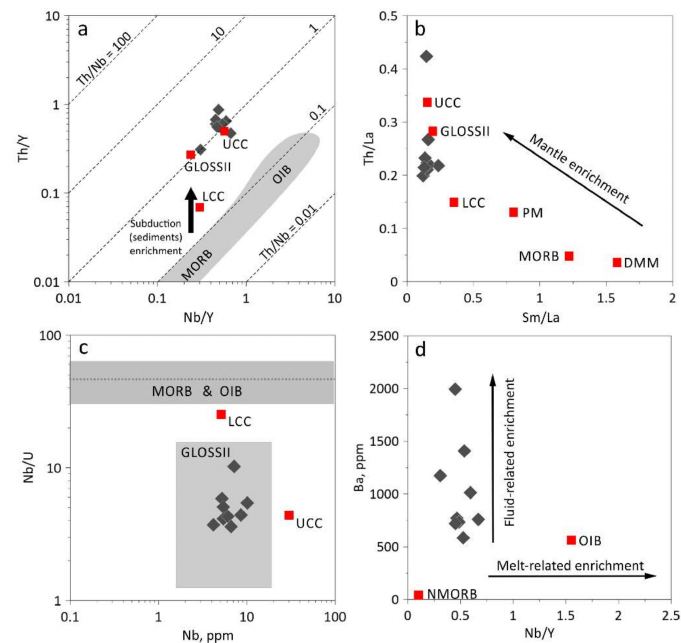
Figure 11. Discrimination diagrams for Chompolo rocks: ( a ) Th-Nb proxy for crustal input